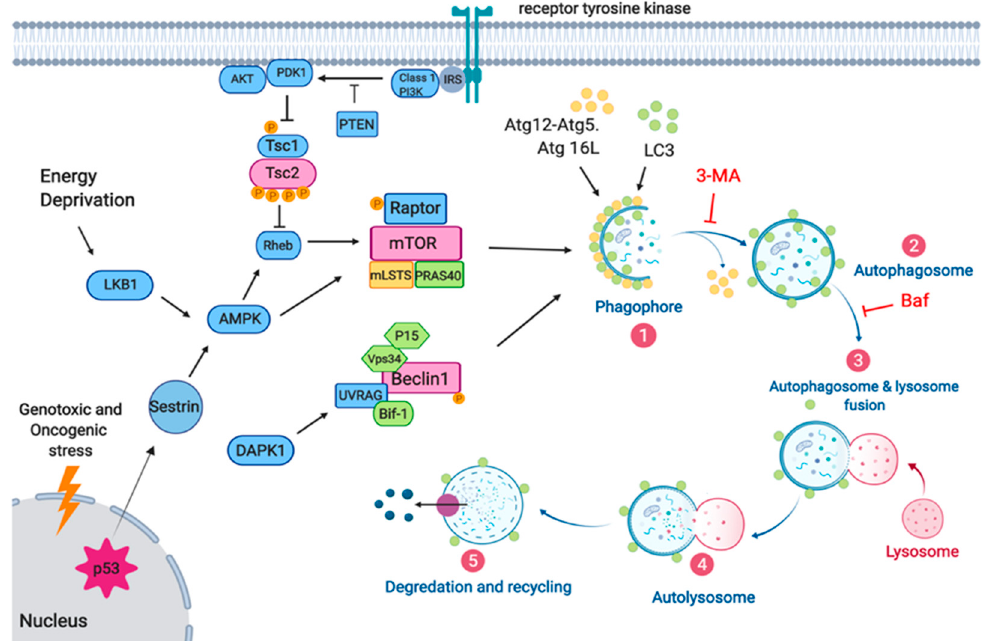
Figure 1. Autophagy regulation pathways in response to stress signal. The figure shows the pathway for the initiation of autophagy through the activation of a receptor tyrosine kinase. The autophagy process includes initiation, elongation, autophagosome formation, lysosome fusion, and degradation. The initiator complex is a base for launching the assembly of the autophagosomal membrane de novo. It consists of Beclin-1, Bcl-2, VPS (vacuolar protein sorting) kinase-34, and Atg14L proteins. The Atg5-Atg12 complex interacts with Atg16L1 and then participates in the elongation of the autophagosomal membrane. Atg4B cleaves LC3I to LC3II, which, after conjugation with PE (phosphatidylethanolamine), turns into an autophagosomal membrane-bound protein directly involved in membrane formation. After fusion, all membrane proteins (except LC3II) involved in this process leave the autophagosome.